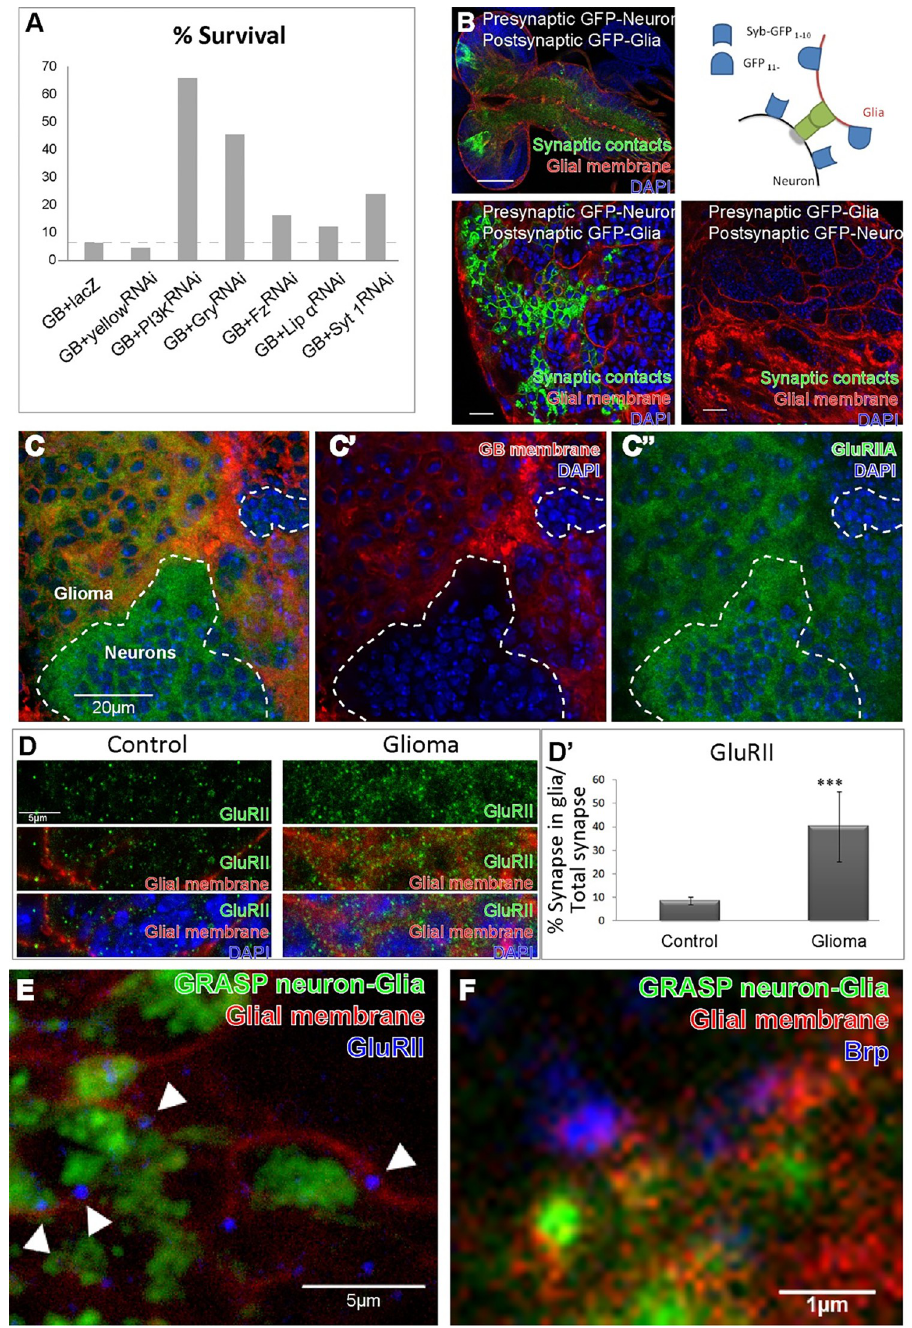
Fig 1. GB cells form synapses with neurons. A) Histogram showing the percentage of viability of flies when glioblastoma (GB) is induced alone (GB+lacZ or GB+yellowRNAi) or combined with PI3K , gry , fz , lip α or syt 1 knockdown in GB cells by RNAi. Percentage corresponds to the number of adult flies that emerged from the pupae for each genotype, relative to the controls (siblings without repoGal4 , considered 100% of viability). Absolute numbers and percentages are in S1 Table, B top left) confocal image of GRASP+ signal in larval brain when presynaptic Syb-GFP 1-10 fragment is expressed in neurons and CD4-GFP 11 fragment is expressed in GB cells; B bottom left) magnification of above; B top right) Diagram of GRASP technique; B bottom right) confocal image of GRASP–signal when presynaptic Syb-GFP 1-10 fragment is expressed in glioma cells and CD4-GFP 11 fragment is expressed in neurons; Synaptic contracts are shown in green (GFP), glial membrane are in red (repo > myrRFP) and all nuclei (DAPI) are in blue. C) Confocal image of larval GB brain, carrying the protein-trap GluRIIA-RFP (green), showing glial